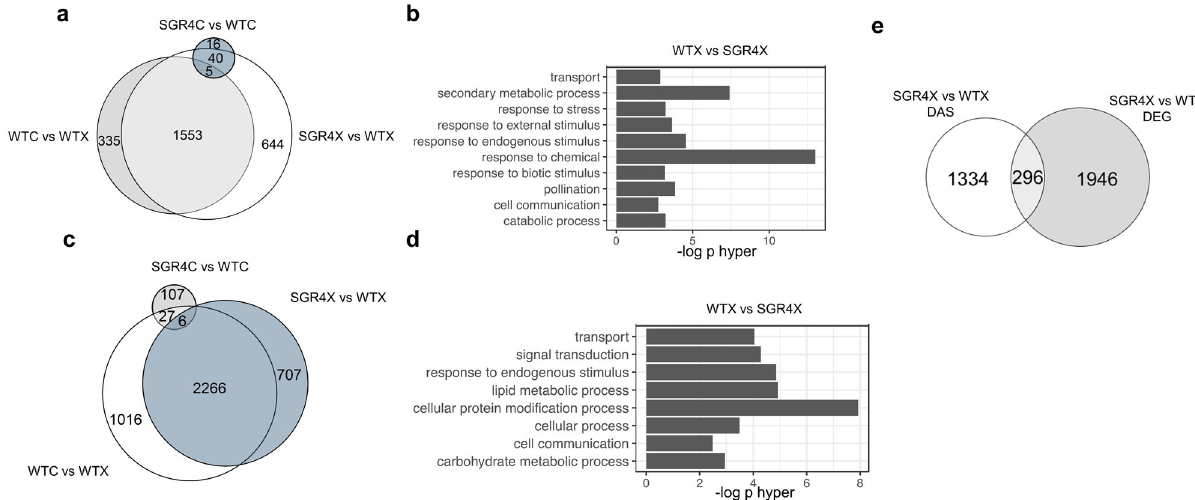
Fig. 2 SGR4 protects against GEX1A-induced gene expression and splicing inhibition. a Overlap of differentially expressed genes (DEGs) between WT and SGR4 under mock or GEX1A treatment. One-week-old rice seedlings were treated with 0.3 μ M GEX1A for 6 h. A high number of DEGs were observed after GEX1A treatment in WT while SGR4 appears insensitive to GEX1A. SGR4 comparison with WT under mock treatment show very few number of DEGs. b GO enrichment analysis of the DEGs regulated by GEX1A. c Venn diagram showing the overlap of differentially spliced events (DAS) between WT and SGR4 . d GO enrichment of GEX1A-responsive DAS genes. e Overlap of DEG with DAS events for SGR4 and WT under GEX1A treatment.